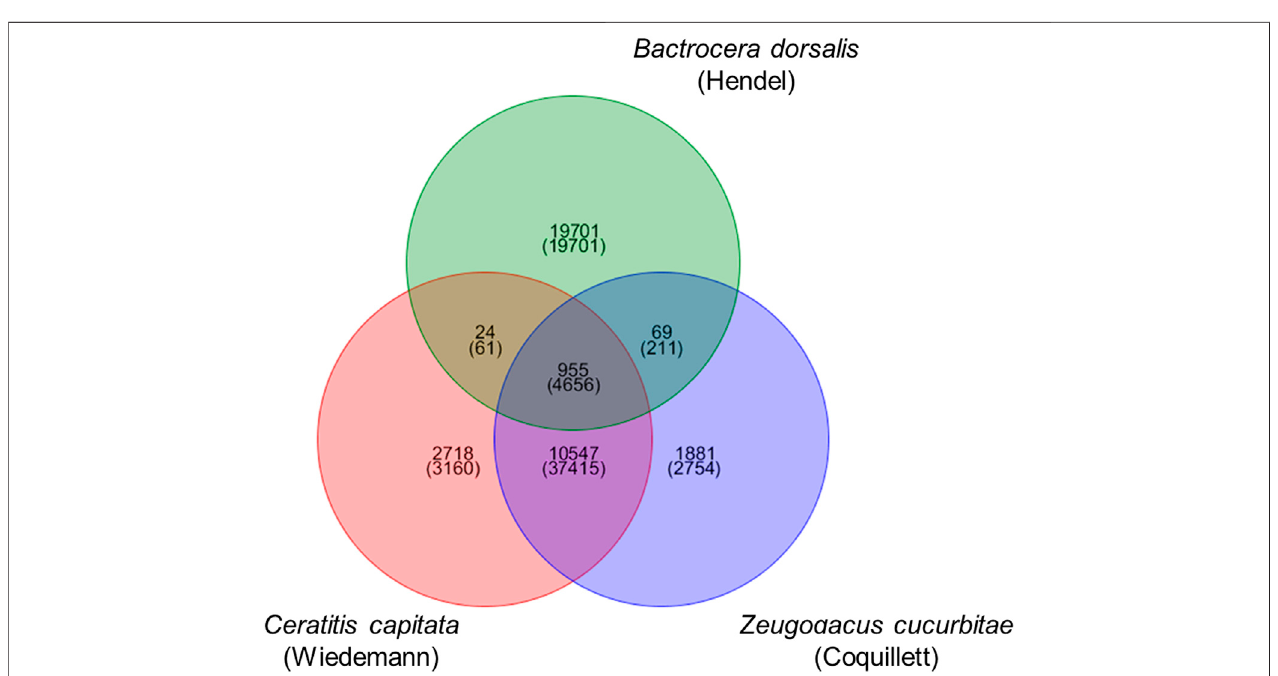
FIGURE 1 | Venn diagram of the gene family of Zeugodacus cucurbitae (Coquillett), Bactrocera dorsalis (Hendel), and Ceratitis capitata (Wiedemann). Note: the upper number in each section represents the number of gene families, and the lower number represents the number of genes.